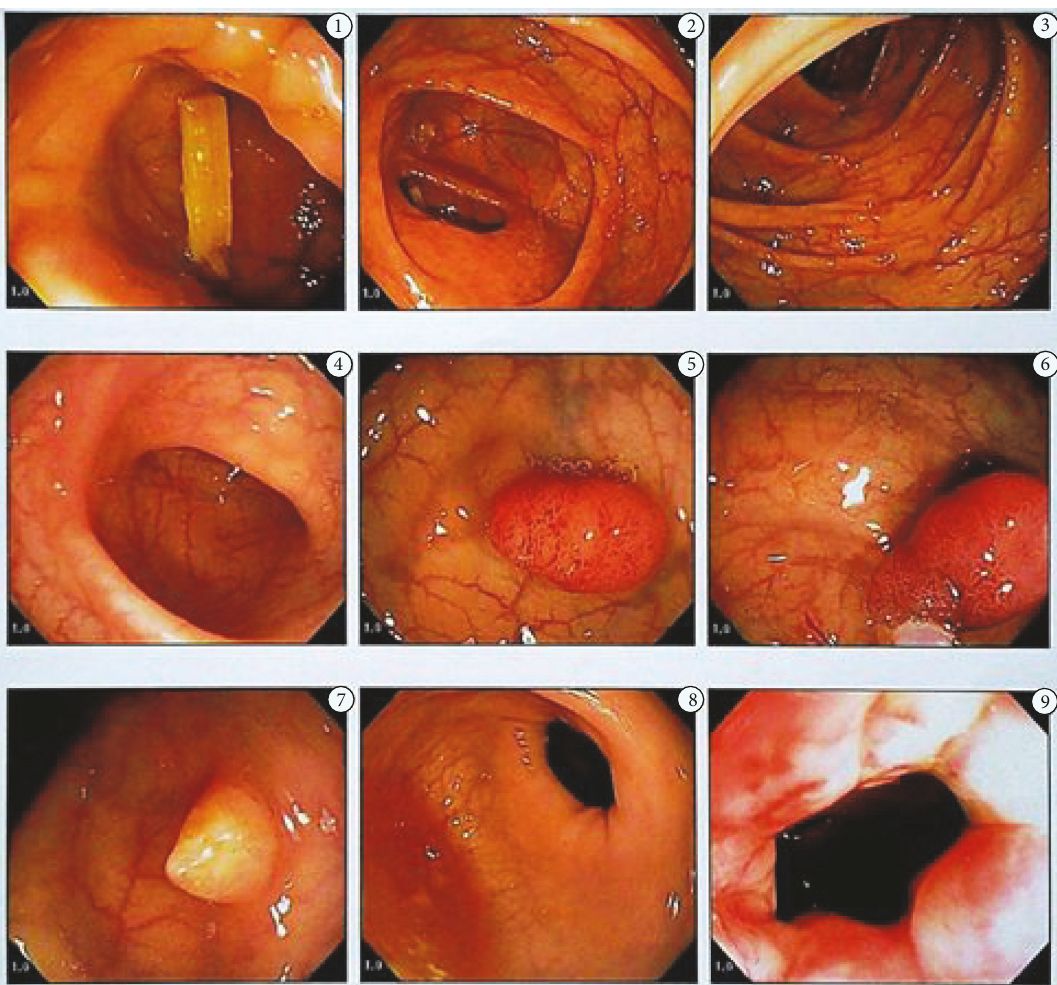
Figure 2: Images of videocolonoscopy that show the presence of